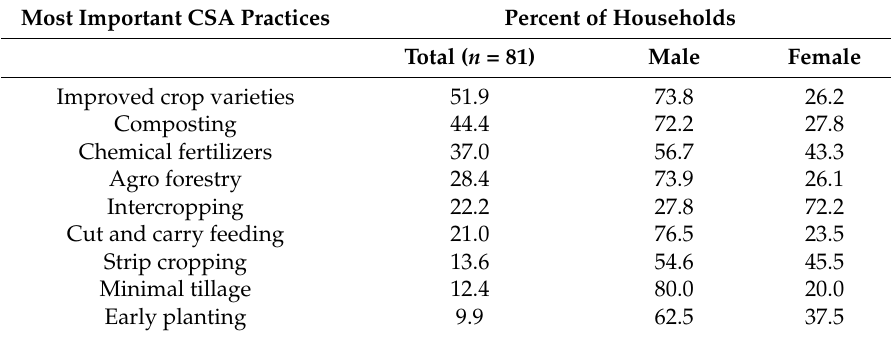
Table 5. Gender differentiated CSA practices cited as the most important for adapting to climate change by farmers.